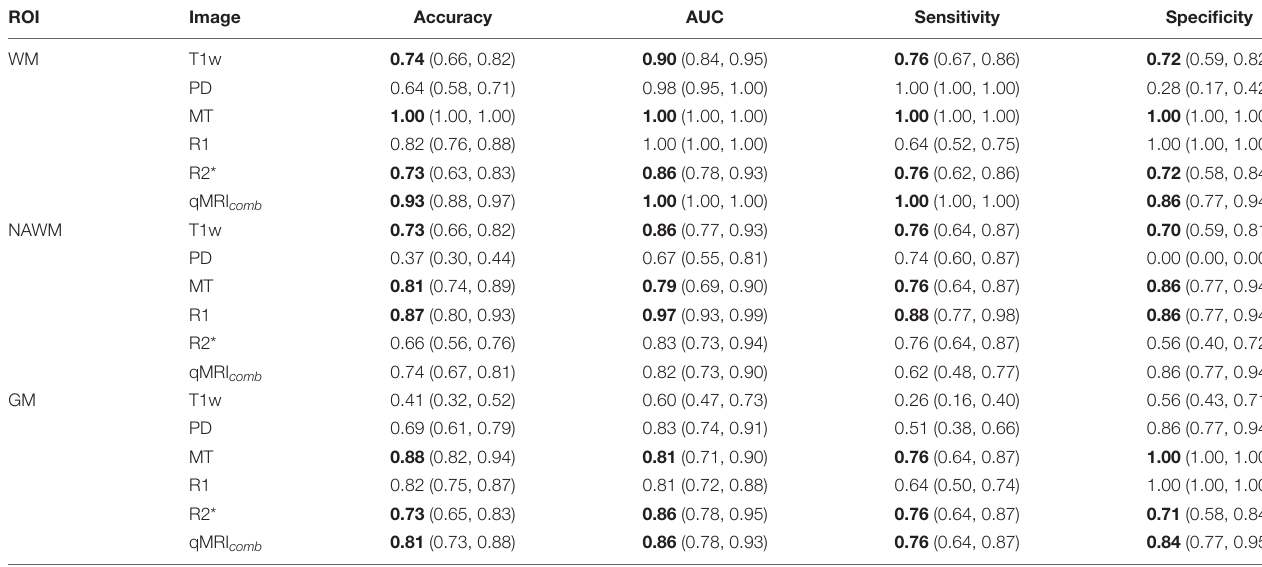
TABLE 5 | Logistic regression model performances on testing data showing the median (90% CI) for each image and tissue type (ROI) (median values above 0.7 for all the performance metrics for the same model are highlighted with bold font). ROI Image Accuracy AUC Sensitivity Specificity WM